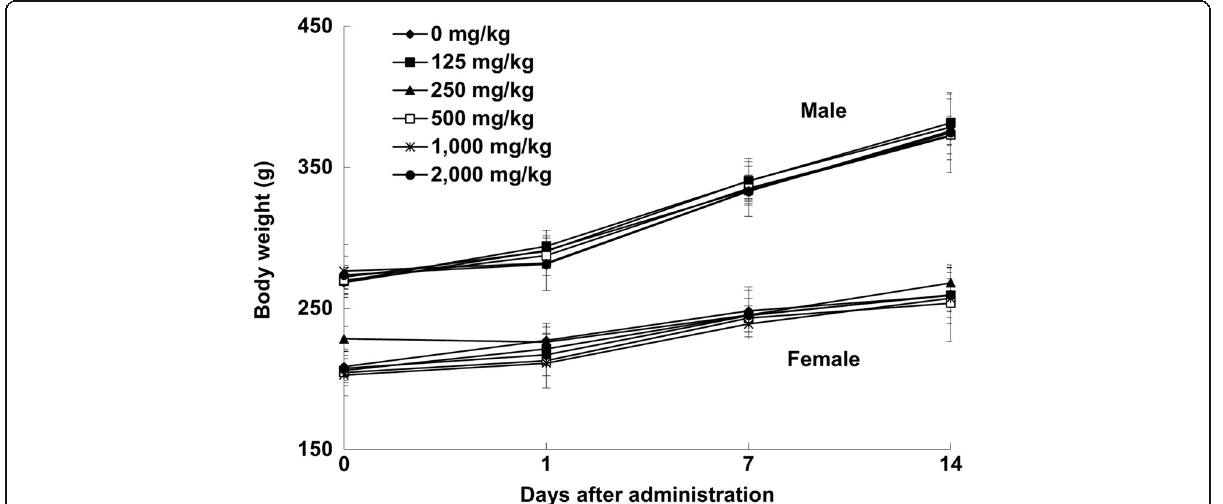
Fig. 1 Body weight values of male and female SD rats orally administered with Tiglium seed extract in single dose toxicity study. Data are expressed as means ± SD ( n =3/sex/group)